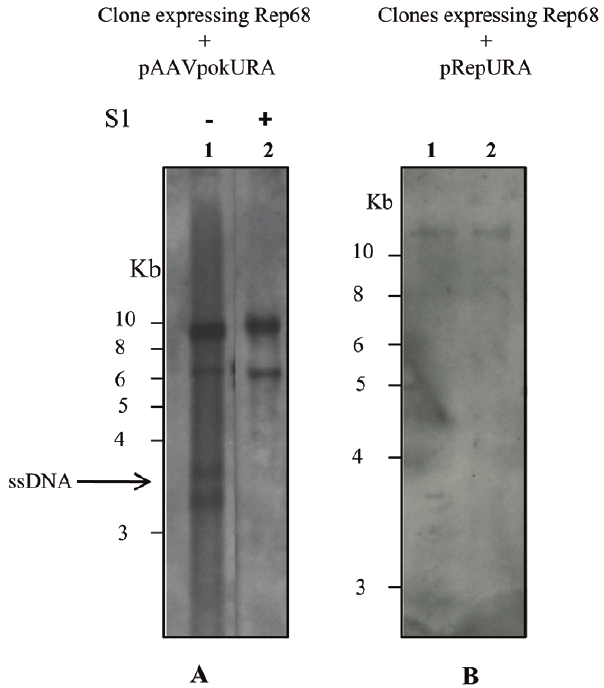
Figure 7. ssDNA formation is dependent on ITRs and Rep68. Southern blot of low M r DNA obtained from a clone expressing Rep68 transformed with pAAVpokURA (A) or pRepURA (B) and probed with URA3. (A) Lane 1 shows low M r DNA undigested and lane 2, low M r DNA subjected to S1 nuclease. (B) Low M r DNA of two different clones (lane 1 and 2) expressing Rep68 and transformed with